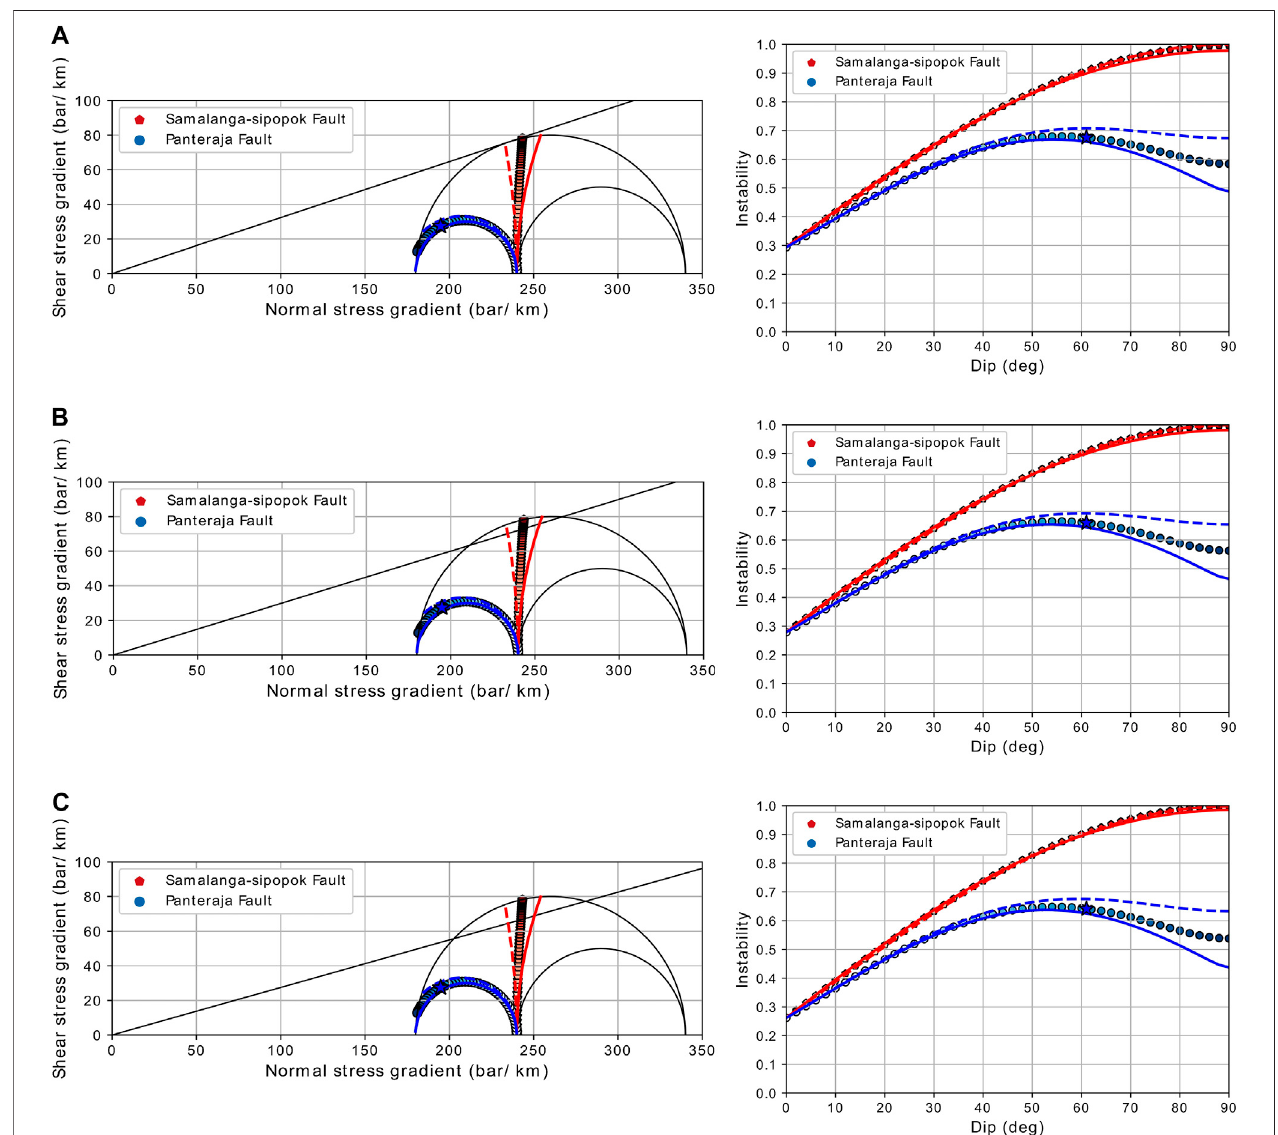
FIGURE 7 | Instability results with constant strike values 43.6 ° for Panteraja and 180 ° for Samalanga-Sipopok Faults. Dip values were varied from 0 ° to 90 ° . The coef fi cient friction ( μ ) is 0.32 for (A) , 0.30 for (B) , and 0.28 for (C) . The right pane is instability vs. dip values and the left pane is the Mohr diagram. Regional maximum horizontal stress orientation is N39 ° ± 3.9 ° E; N35.1 ° E for the dashed line, and N42.9 ° E for the solid line, but N39 ° E for the pentagon and circle line. Star shows Panteraja Fault with strike 43.6 ° and dip 61.2 ° .